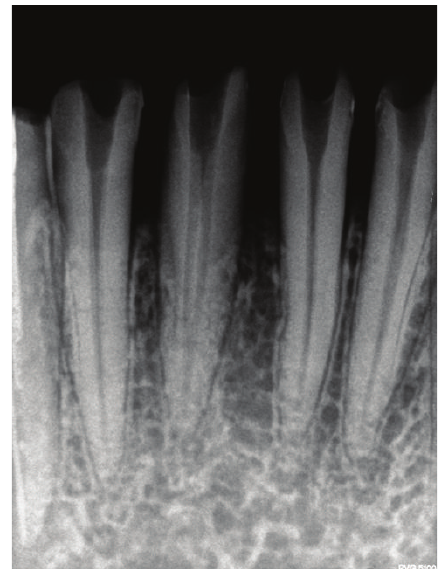
Figure 2: Radiograph showing modified access opening.